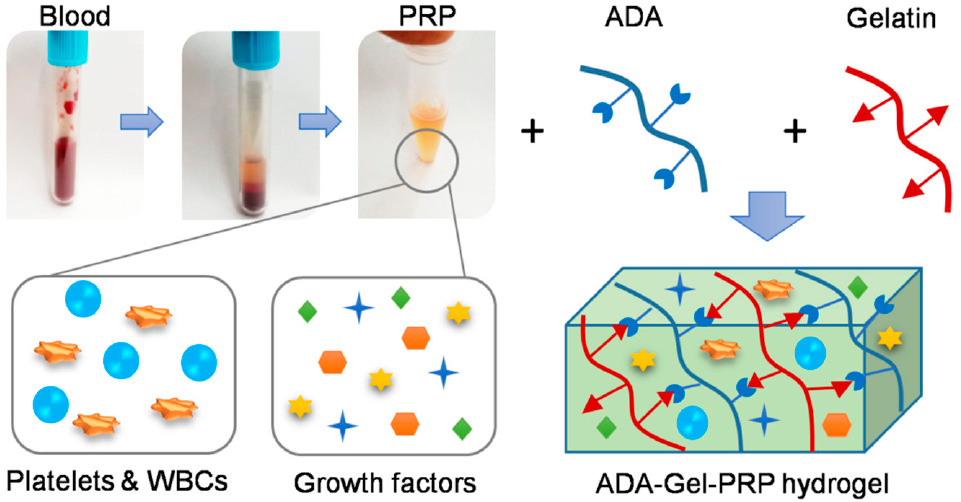
Figure 1. Schematic of ADA–Gel–PRP (dialdehyde–gelatin–platelet-rich plasma) hydrogel-based bioink formulation : the hydrogel network forms by covalent interaction of the aldehyde group of ADA with amine groups of gelatin through Schiff base reaction, incorporating components of PRP.